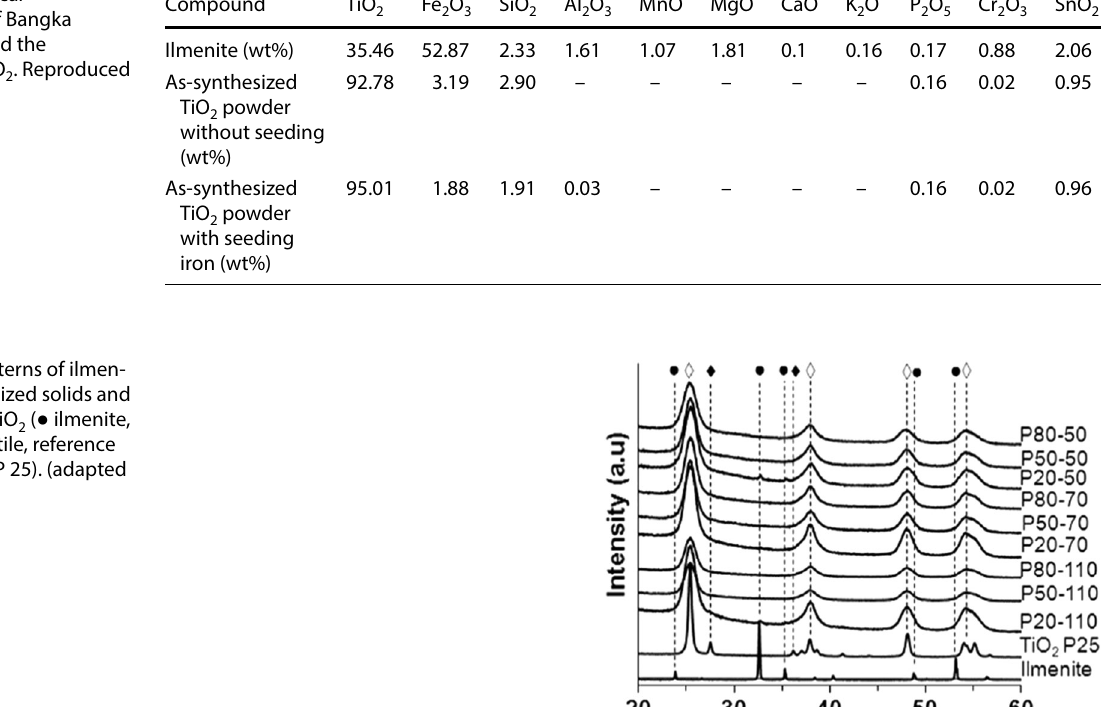
Table 4 Chemical composition of Bangka ilmenite ore and the synthesized TiO from Ref. [61]